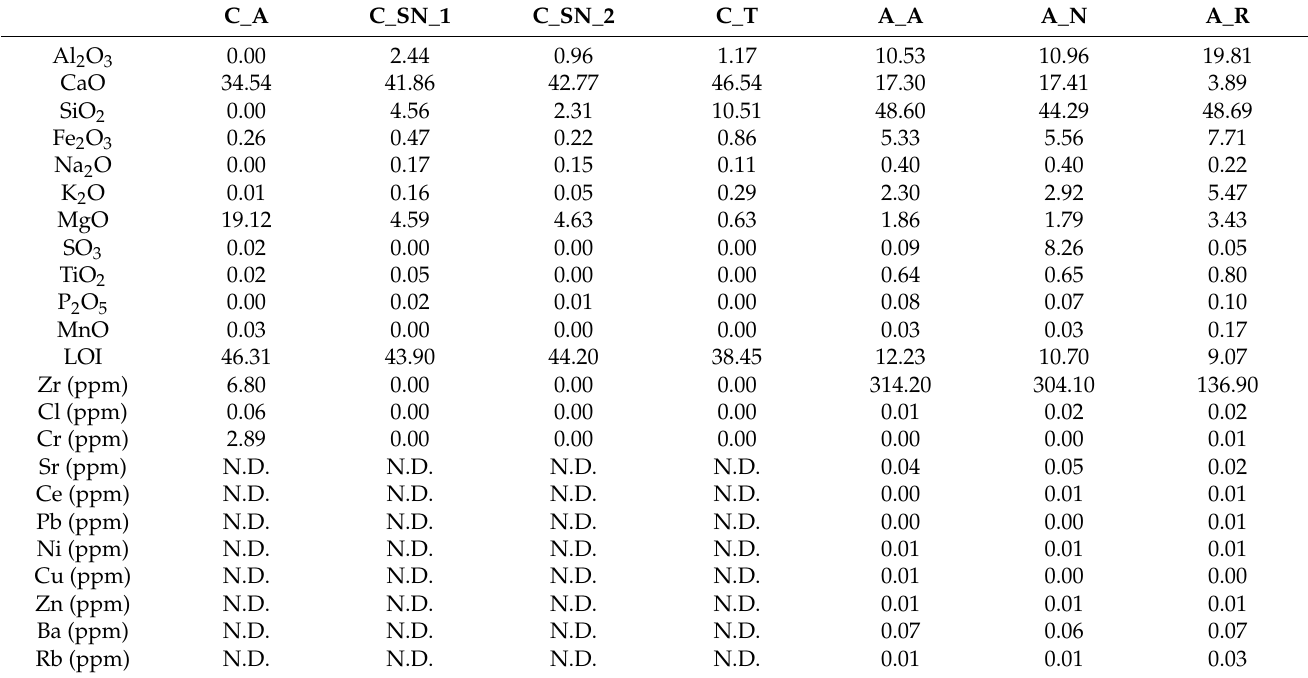
Table 2. Chemical composition (XRF, wt %) of the raw materials. N.D.: not detected.